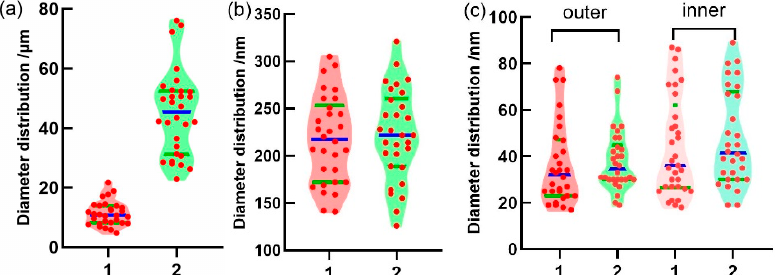
Figure 3. ( a ) Micropore diameter distribution of the hollow fiber sheath and the SF aerogel core. ( b ) Diameter distribution of sub-micron pores in the hollow fiber and aerogel fiber sheaths. ( c ) Diameter distribution of nanopores on the inner and outer walls of hollow fibers and aerogel fibers. 1—CA/PAA hollow fiber, 2—CA/PAA-wrapped SF aerogel fiber.